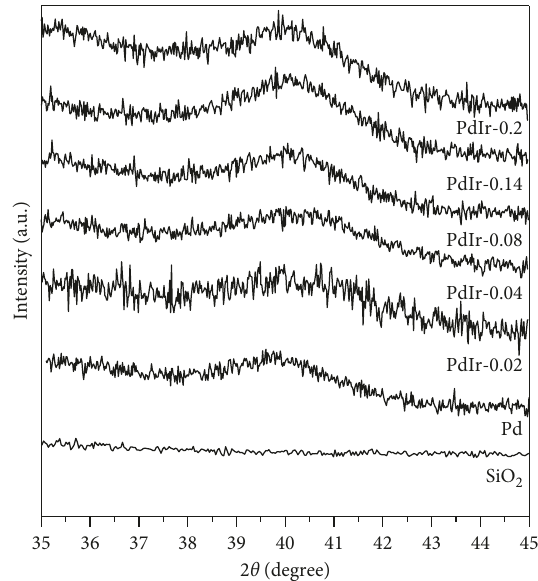
2 , Pd/SiO 2 , and PdIr- Figure 2: XRD diffraction patterns of silica-supported PdIr-0.02, PdIr-0.04, PdIr-0.08, PdIr-0.14, and PdIr-0.2